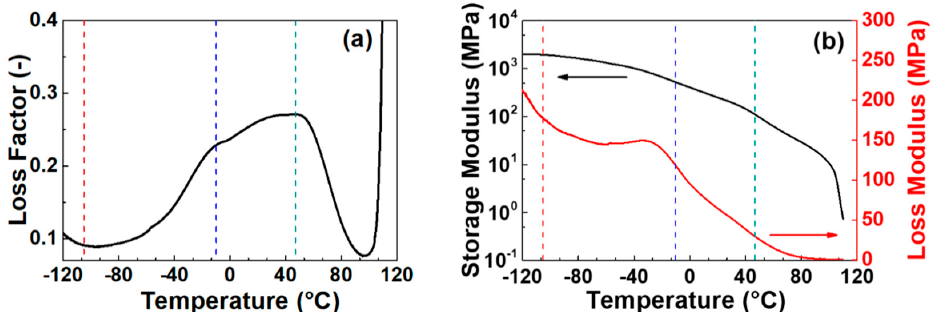
Figure 6. Dynamical mechanical analysis as a function of temperature of a LDPE sample. Loss factor ( a ), storage modulus and loss modulus (MPa) ( b ). Vertical dot lines at T = − 105, − 10 and 47 °C represent the second-order transition temperatures .